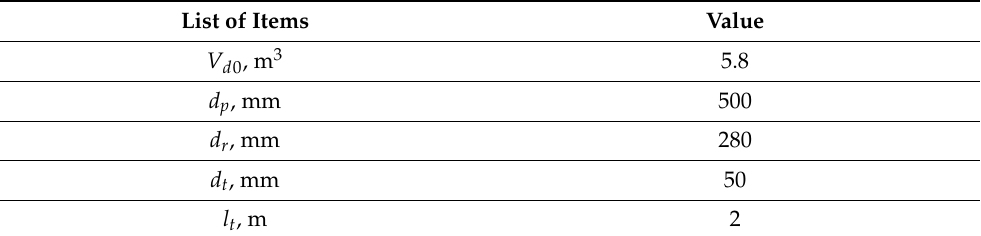
Table 4. Specifications of the